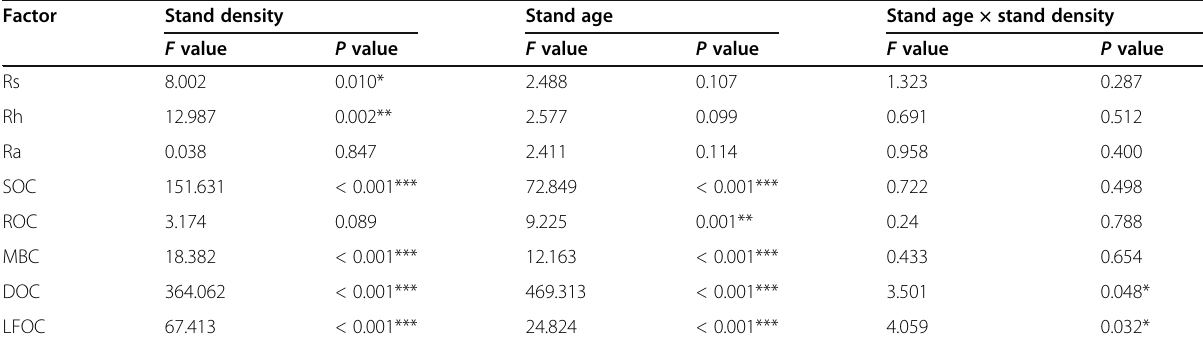
Table 2 Analytical results of the factors affecting Rs, Rh, Ra, and soil labile organic carbon. In the table, asterisk represents statistical significance, in which * P < 0.05, ** P < 0.01, and *** P < 0.001. Rs, soil respiration; Rh, heterotrophic respiration; Ra, autotrophic respiration; SOC, soil organic carbon; DOC, soil dissolved organic carbon; MBC, microbial biomass carbon; LFOC, light fraction organic carbon; ROC, readily oxidized